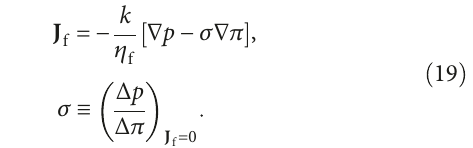
Note: The mobilities of ions in water is 298K NaCl aqueous